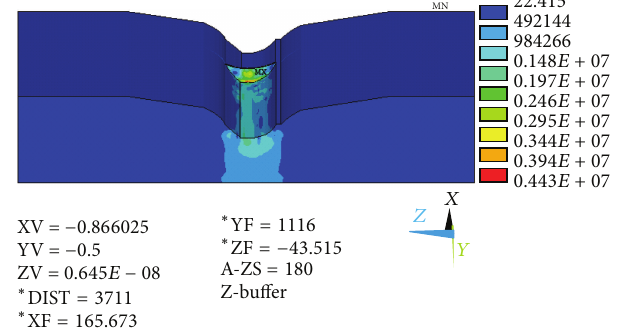
Figure 15: Nephogram of the equivalent